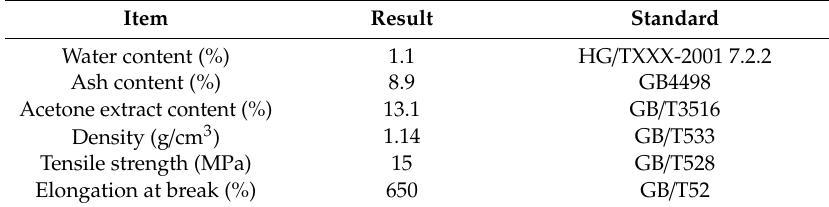
Table 2. Technical parameters of crumb rubber.